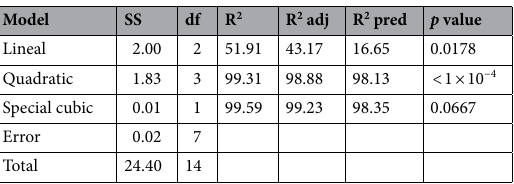
Table 3. ANOVA of the regression models for biomass production of L. sakei ACU-2. The different values of R 2 are expressed as % p < 0.05 is significant.